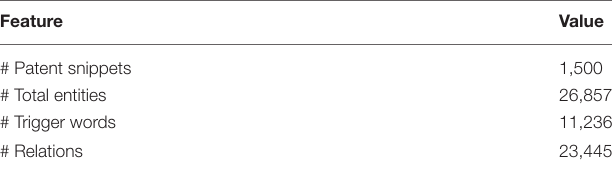
TABLE 3 | Overall statistics of the annotated